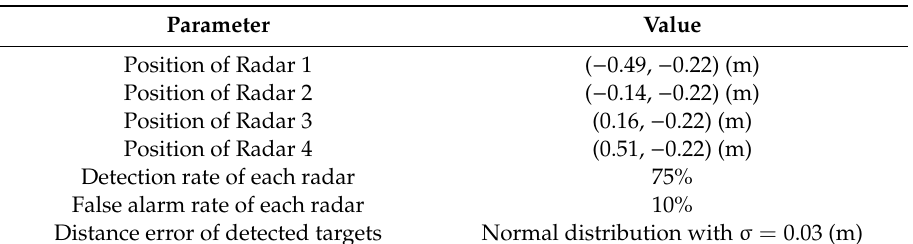
Table 2. Simulation Setup.